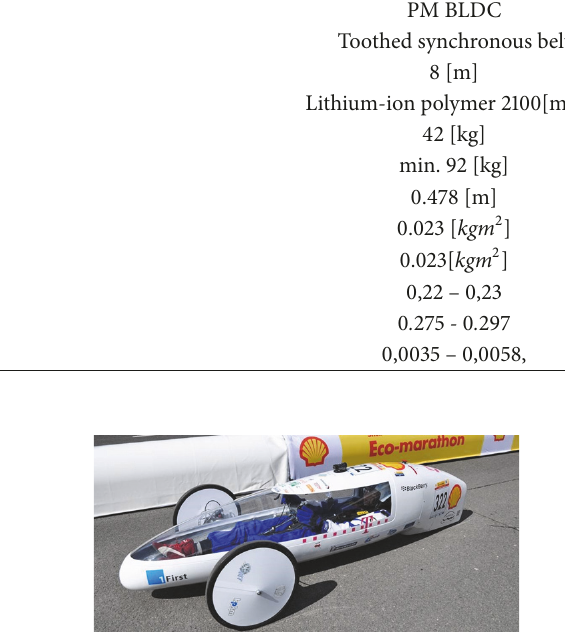
Figure 9: Research object: prototype electric vehicle “MuSHELLka” (photo by M. Wyle˙zoł,